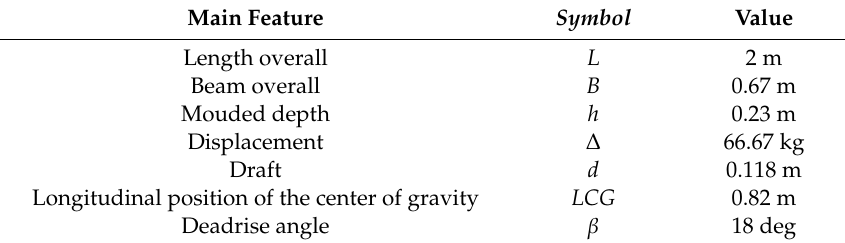
Table 10. Model parameters of the prototype.